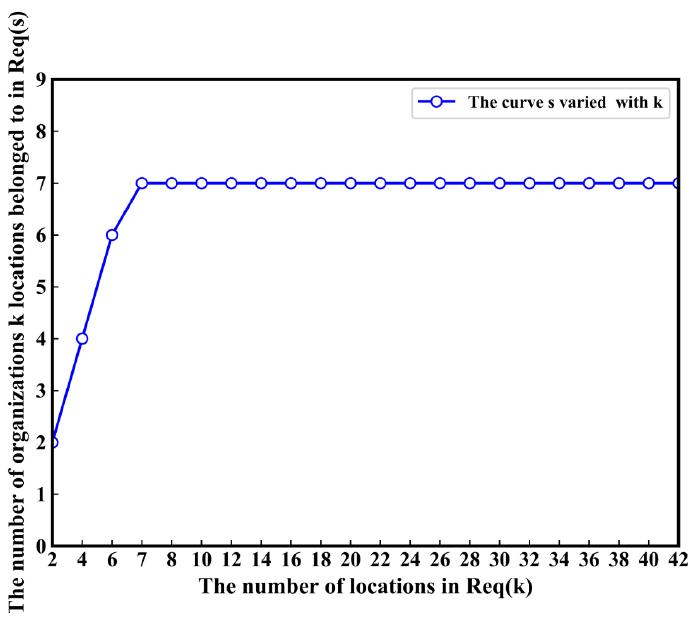
Figure 10. The value of s that balances the privacy protection and system overhead varies with k